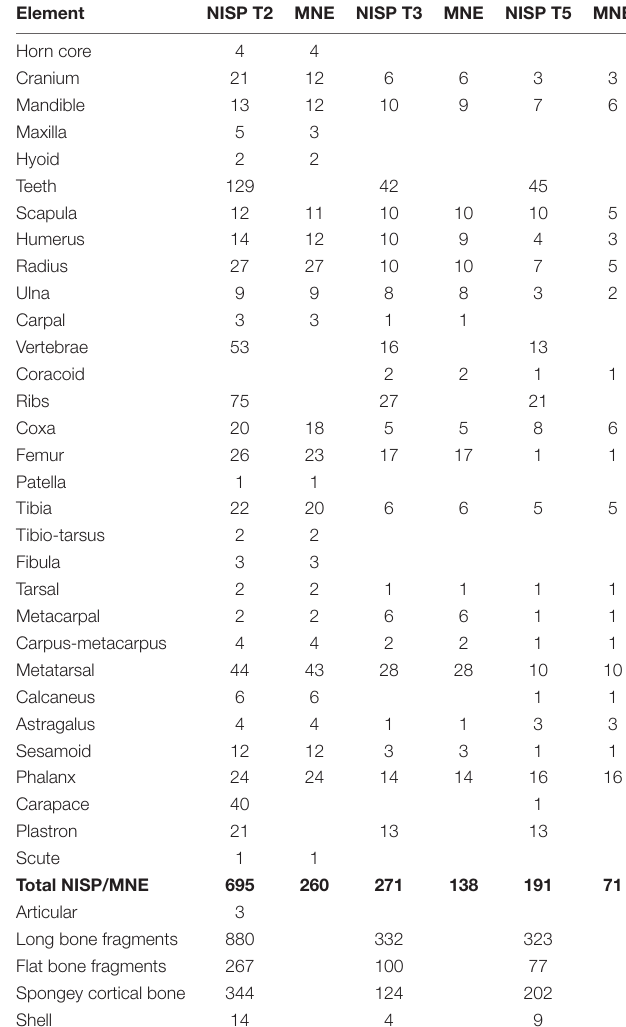
Each column represents the NISP and MNE of all the identified skeletal elements occurring at Ewass Oldupa.